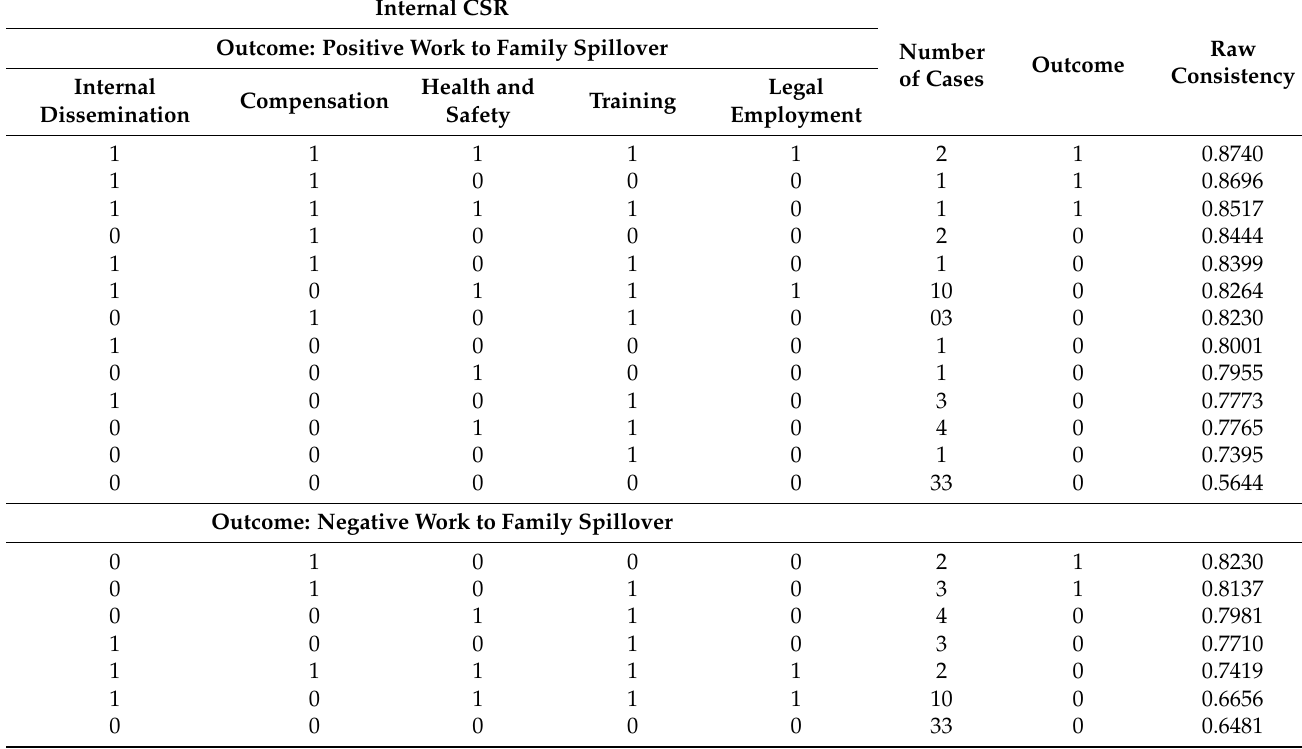
Table 2. The truth table for a high level of work–family